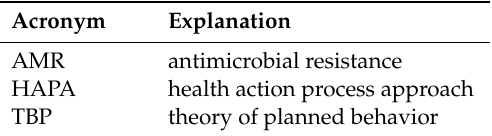
Table A1. List of